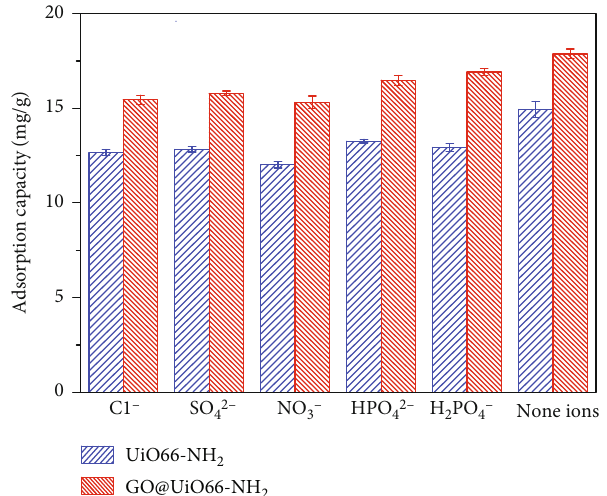
Figure 4: The e ff ect of competing anions on the adsorption of Sb (III) on the prepared